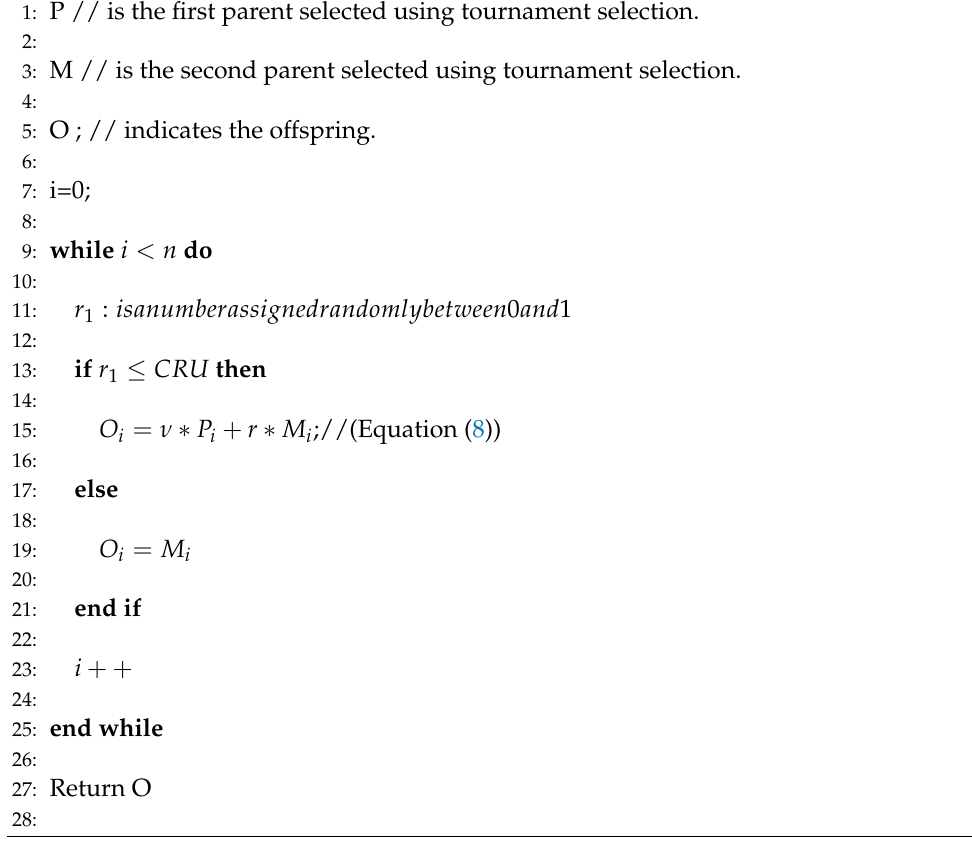
Algorithm 1 Uniform Arithmetic crossover